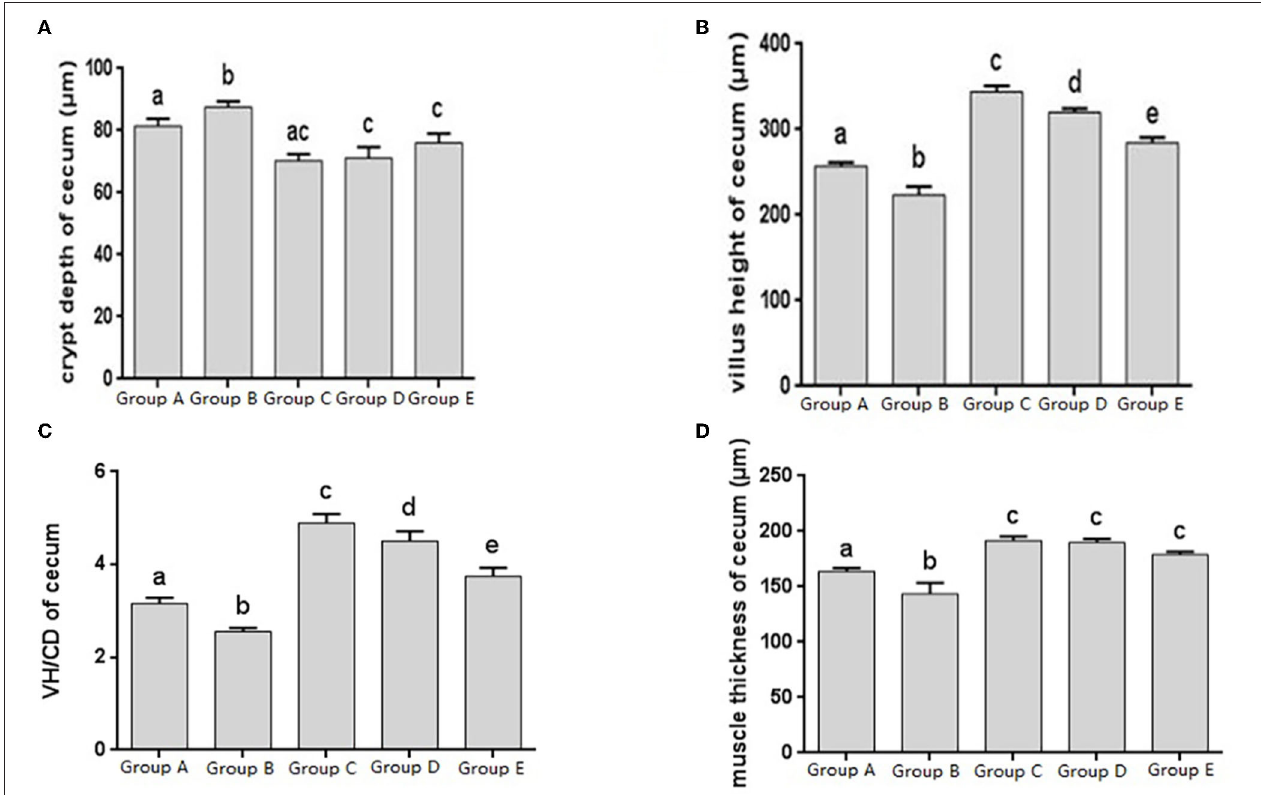
FIGURE 4 | Morphological changes in the cecum of chicks after different treatments. (A) Crypt Depth (CD) of the cecum. (B) Villus height (VH) of the cecum. (C) VH/CD of the cecum. (D) Muscle thickness of cecum. Group A, control group; Group B, infection group; Group C, JYBR-190 pre-fed group; Group D, JYBR-190 fed group; Group E, antibiotic group. Data are expressed as mean ± standard deviation (SD). Different lowercase letters on the columns indicate significant differences ( P < 0.05); the same lowercase letters indicate no significant difference ( P >